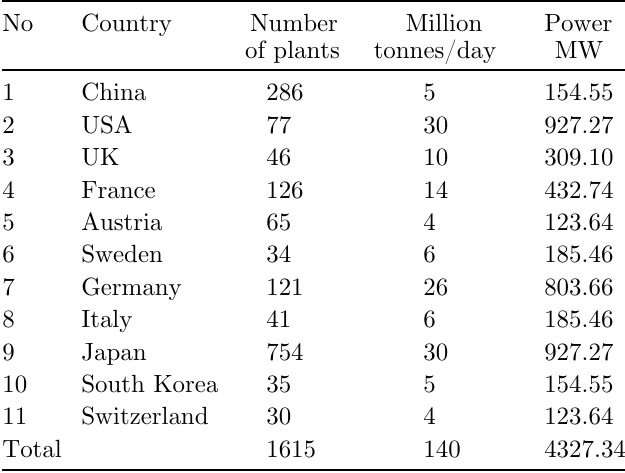
Table 3. Power generation from 1615 plants of WtE in major 11